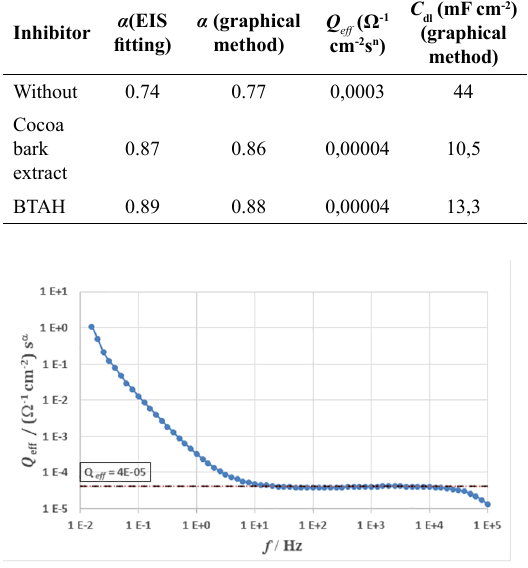
) defined from Eq. (5) eff